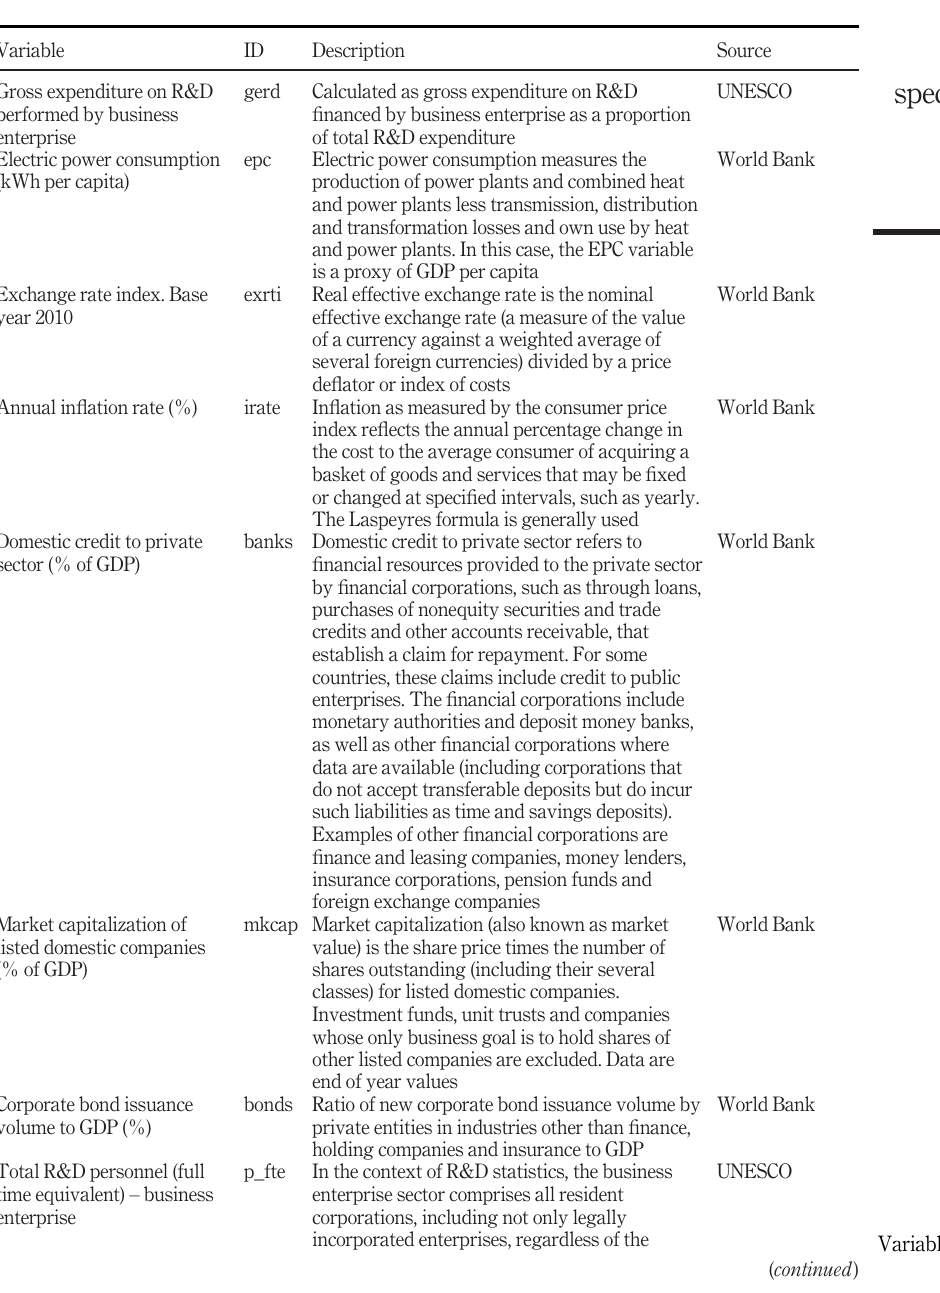
Table 1. Variables,